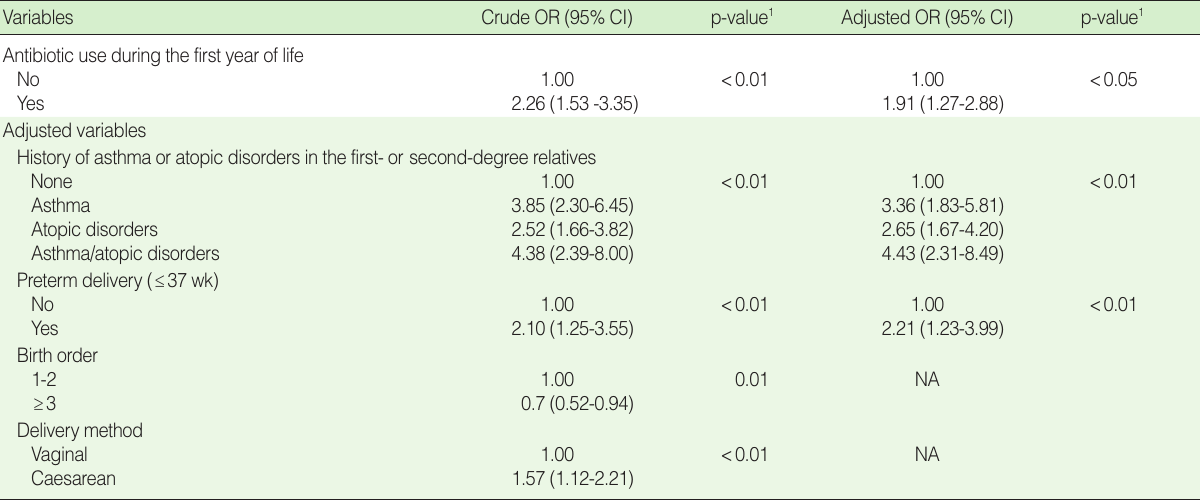
Table 2. Distribution of antibiotic consumption and other risk factors during the first year of life and risk of asthma at 2-8 years